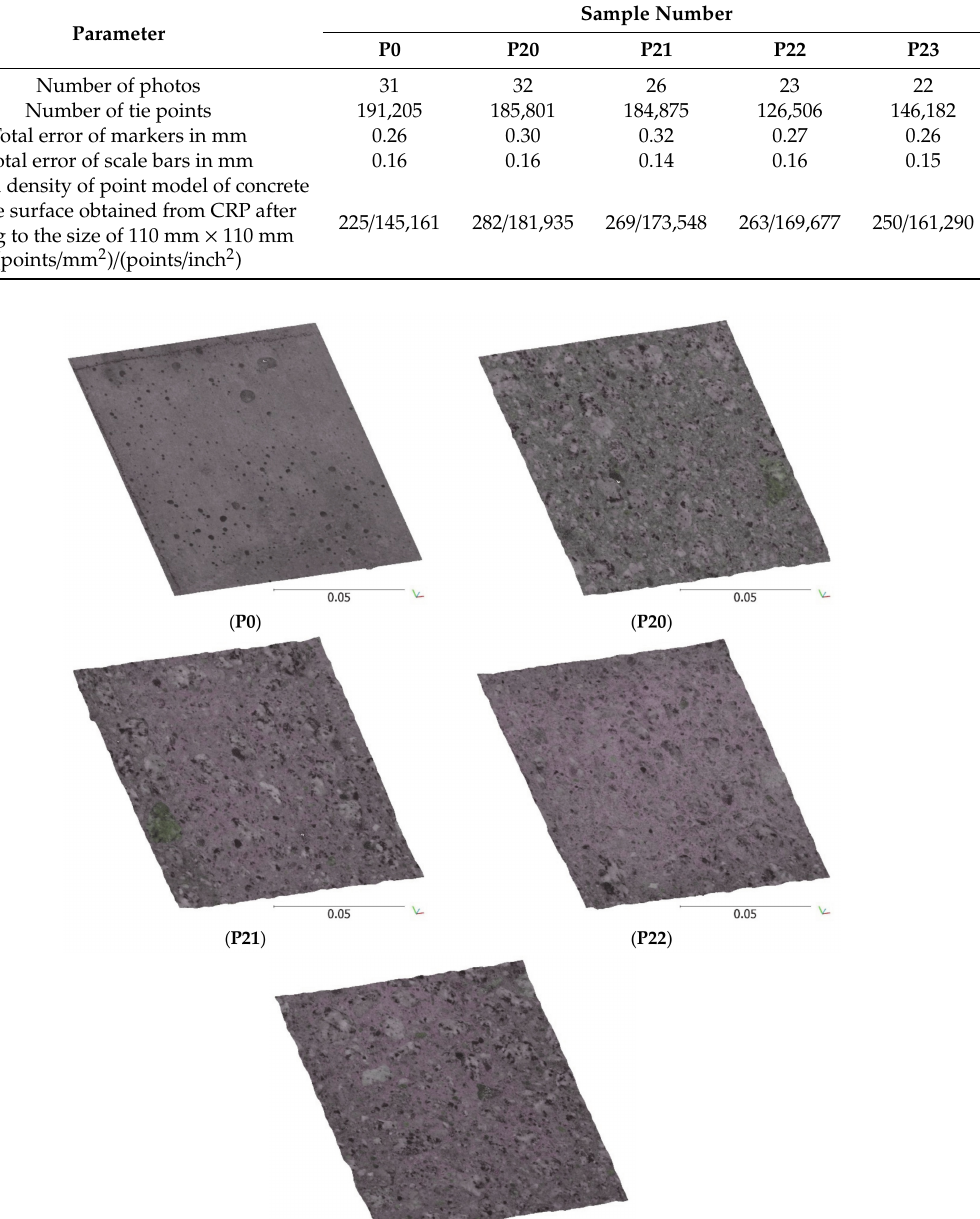
Table 4. The number of tie points and assessment of obtained accuracy for the CRP models of the concrete surface samples.